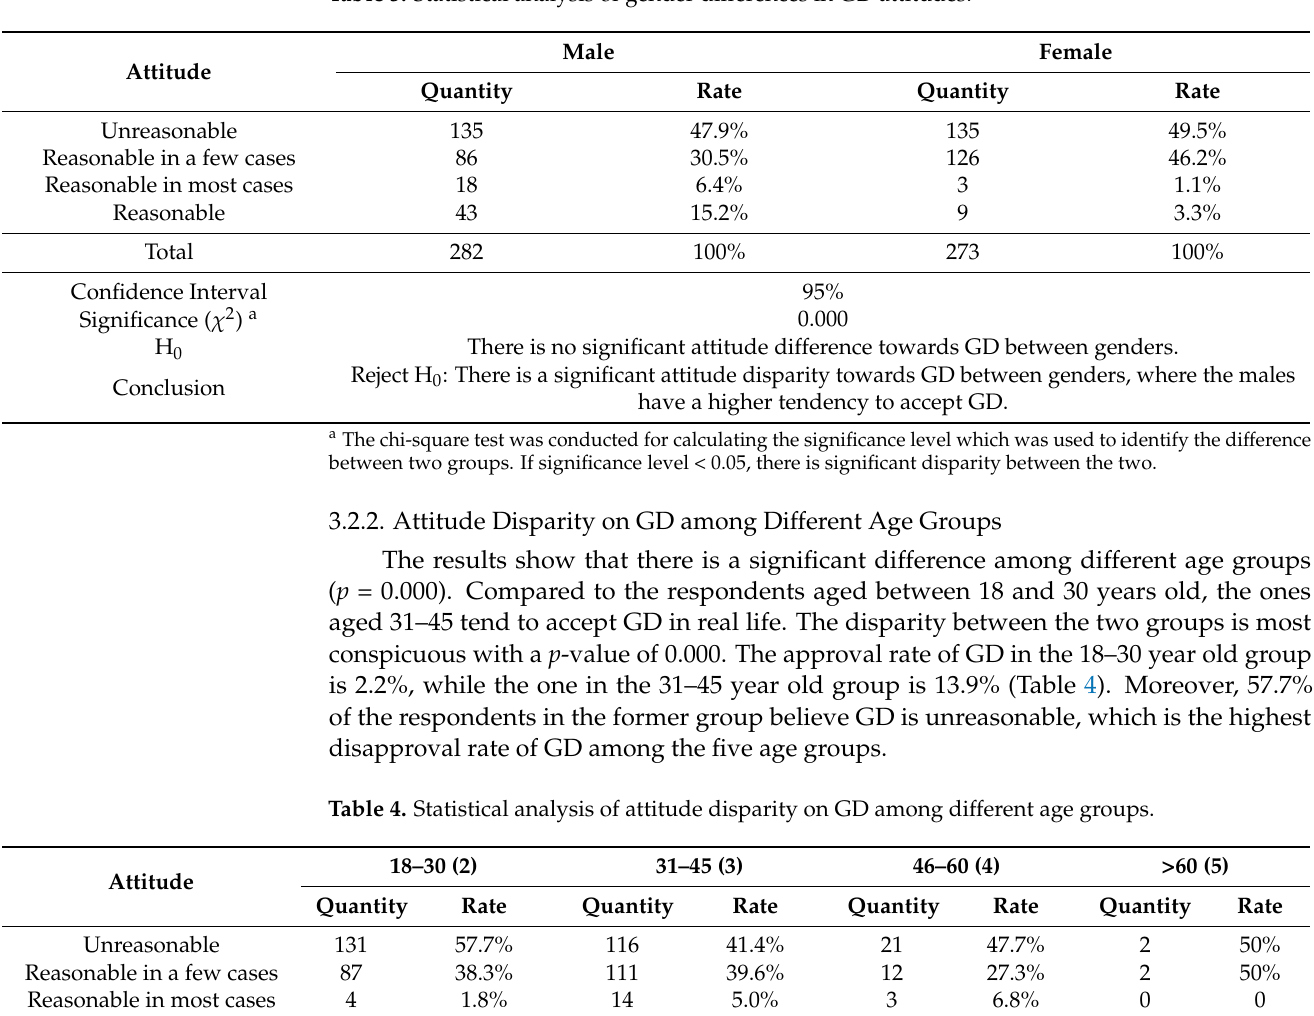
Table 3. Statistical analysis of gender differences in GD attitudes.